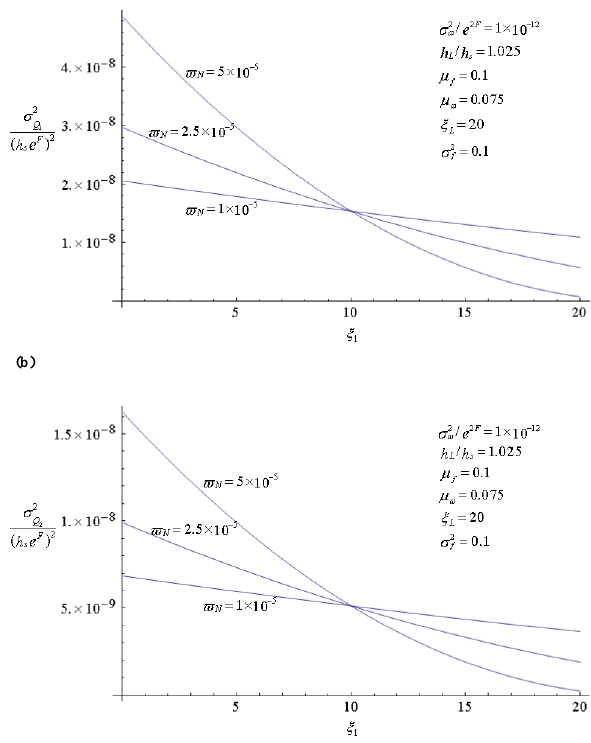
Fig. 5. Dimensionless variance of the (a) longitudinal and of the (b) transverse specific discharge as a function of dimensionless position for various values of $ N